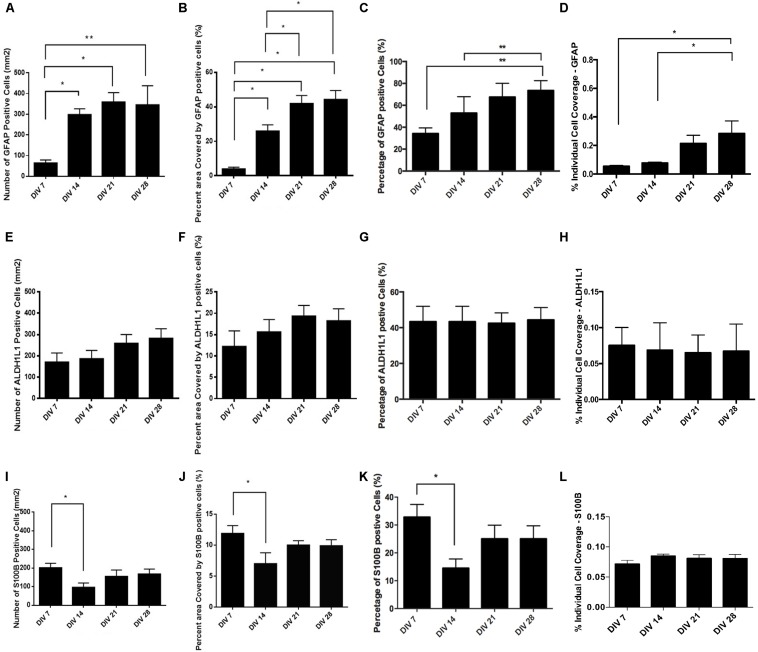
Quantification of astrocyte marker expression: (A–D) – GFAP, (E–H) – ALDH1L1, (I–L) – S100B. (A,E,I) absolute number of marker positive cells per mm2. (B,F,J) Percent (%) area covered by marker positive cells. (C,G,K) Percent (%) of marker positive cells. (D,H,L) Percent of area covered by an average marker positive cell. Data expressed as mean ± SEM from three separate experiments, ∗P < 0.05 and ∗∗P < 0.01.